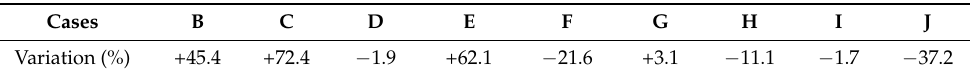
Table 6. Percentage of variation of total of uncomfortable hours of the others nine cases relative to Case A (Reference